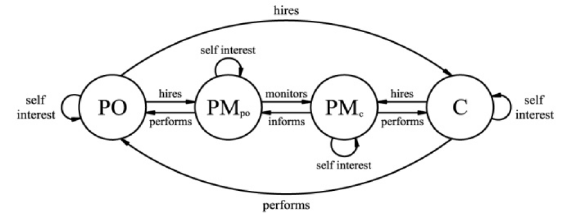
Fig. 2. Principal-agent theory framework for construction projects (PO: Project owner, C: Contractor, PMpo: Project owner’s project manager, PMc: Contractor’s